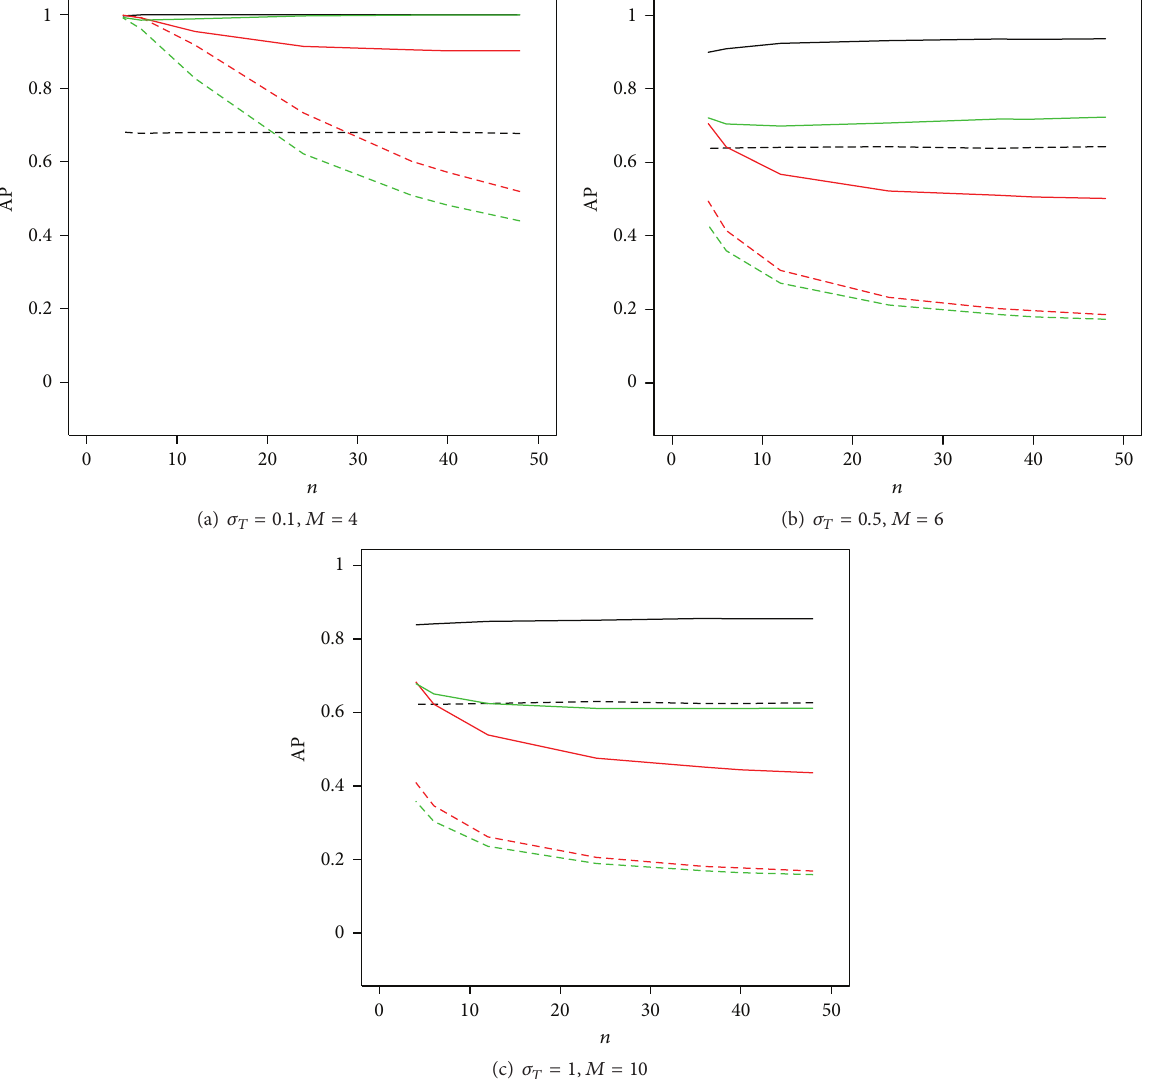
Figure 10: AP for protracted threat using SITMUF joint cusum versus CUMUF for 𝑛 = 4, 6, 12, 24, 36, 40,48 . (Colors correspond to black Σ Σ Σ 1 , red 4 , and green 5 . Solid is SITMUF joint cusum and dashed is CUMUF.) Loss of two years is